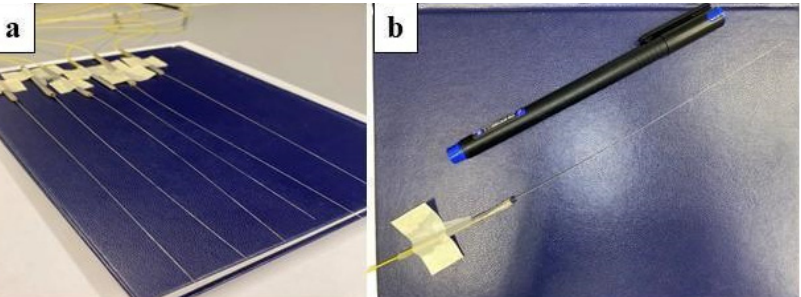
Figure 2. Photographic view of the MgO-doped fibers employed for temperature sensing. ( a ) Photos of the fibers displayed on a grid; ( b ) view of a single nanoparticle-doped optical fiber.